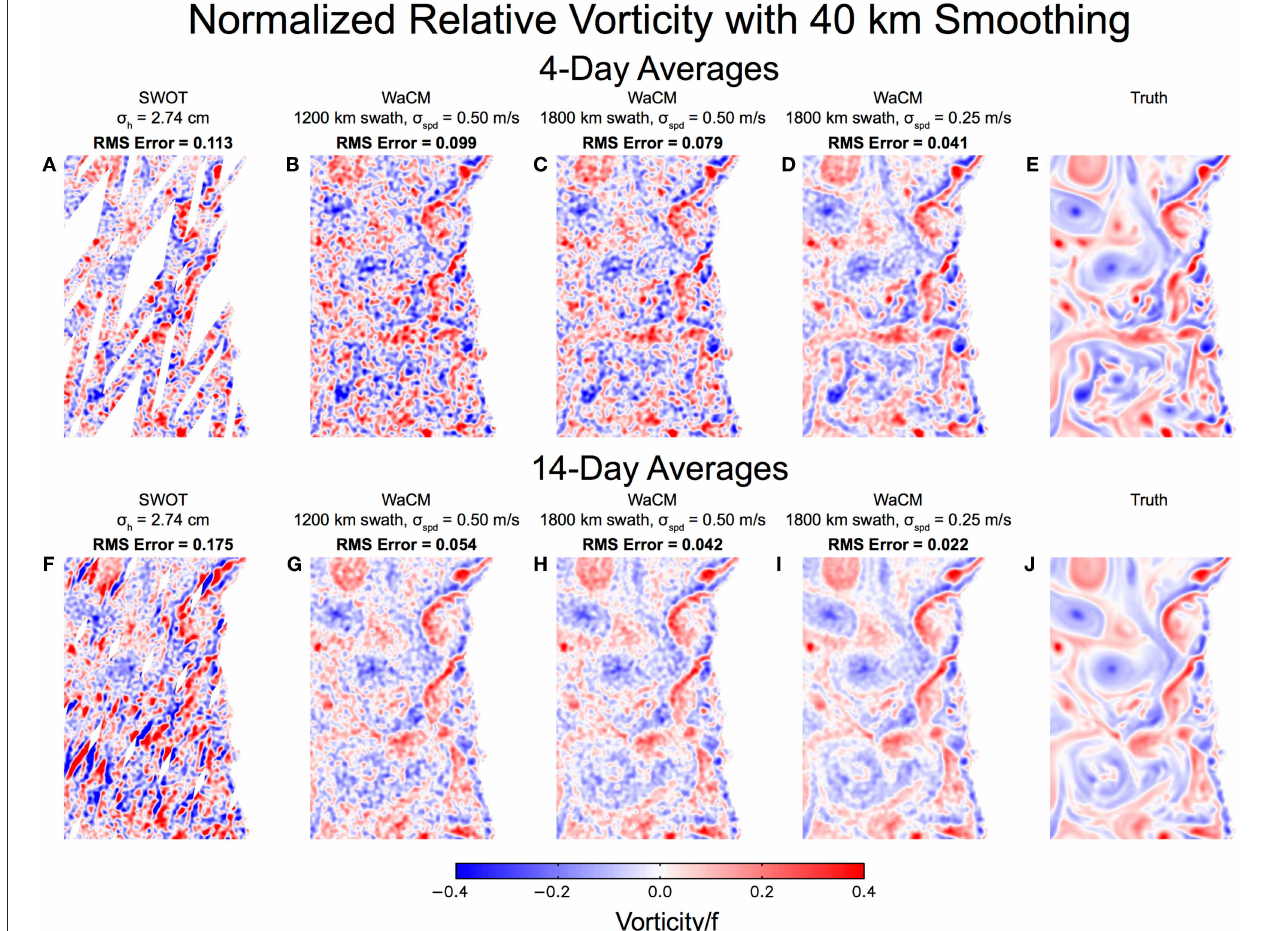
FIGURE 1 | Simulated relative vorticity fields in the California Current System averaged for 4 (E) and 14 (J) days. On the left (A,F) are the same average fields sampled by the NASA/CNES SWOT mission, showing the problems with small swath coverage. The same fields sampled by WaCM assuming an 1,800km swath and 50cm/s (C,H) or 40cm/s speed noise at 5km sampling. The impact of swath width is shown in B,G , to be compared with C,H , where only a 1,200km swath was used for sampling. D,I show the impact of reducing measurement noise from 50 cm/s to 25 cm/s. These results are taken from Chelton et al.